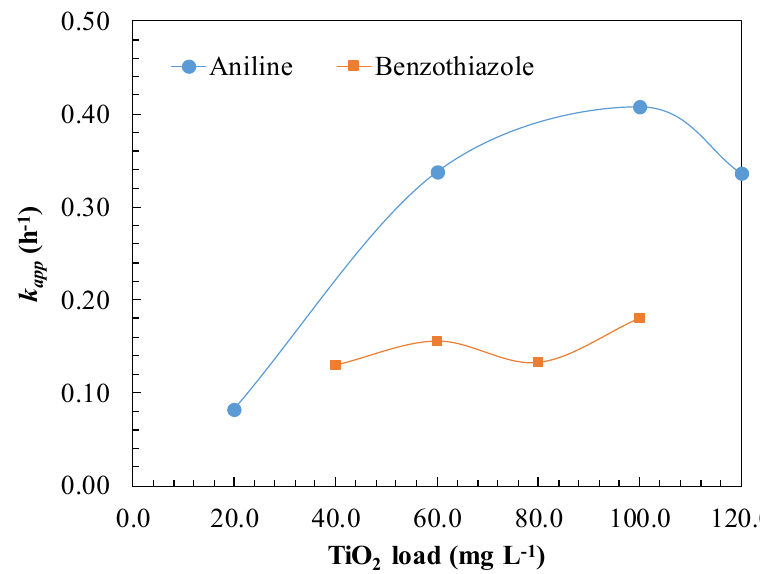
Figure 9. Effect of the suspended TiO 2 dosage on the pseudo-first order kinetic constants for the degradation of aniline or benzothiazole. Experimental conditions: C 0 = 22.0 mg L − 1 ; pH = 12.0 (aniline); pH = 8.0 (benzothiazole); T = 25.0 °C; P = 1.0 atm.